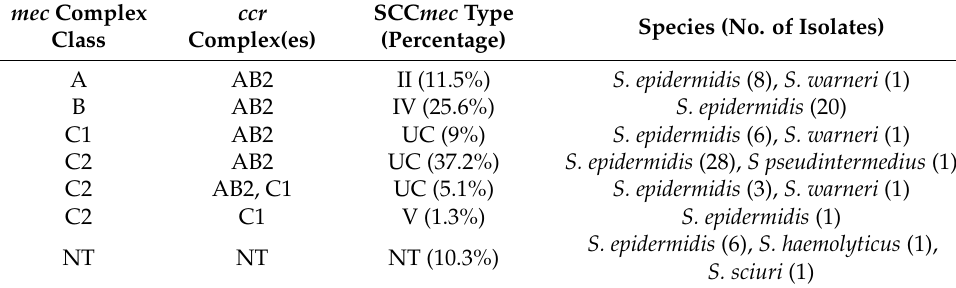
Table 4. mec / ccr complex, SCC mec types, and species and no. of isolates